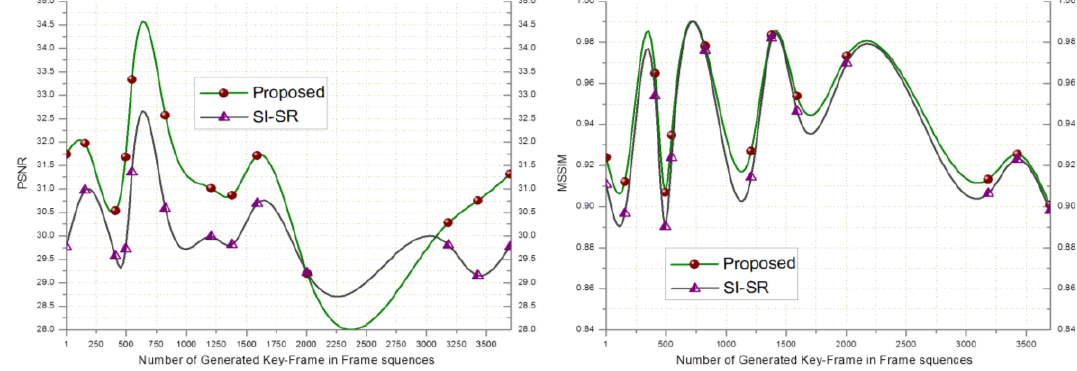
Figure 3. PSNR and MSSIM computed for key-frames of the